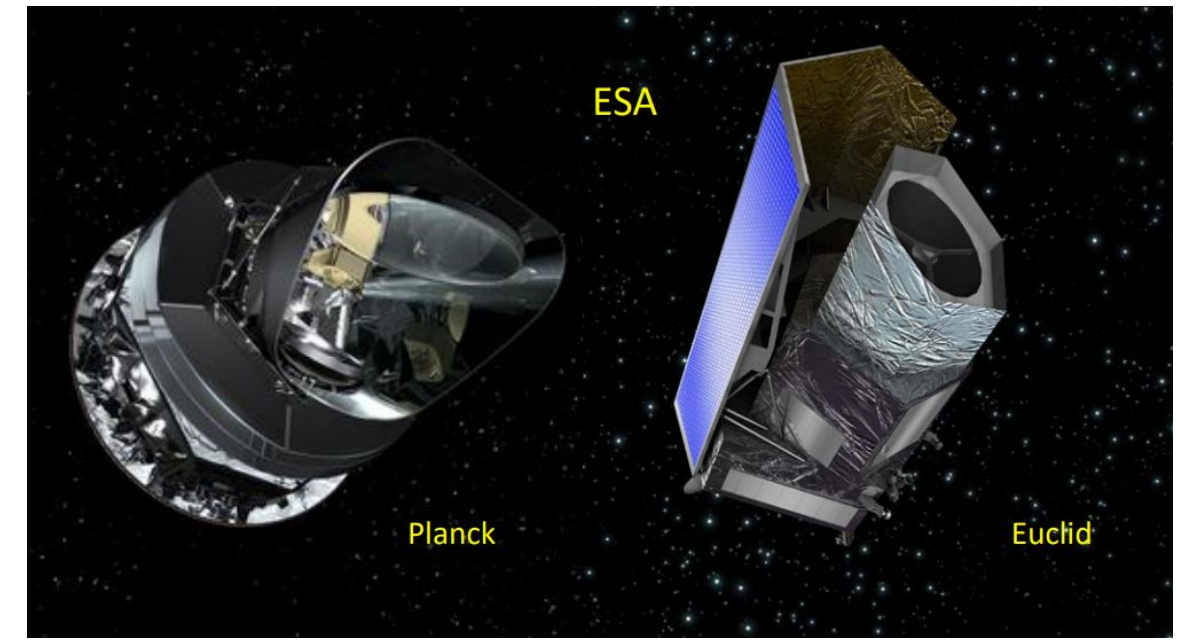
Figure 7. Artistic representation of the two ESA missions Planck and Euclid put together for visual comparison.